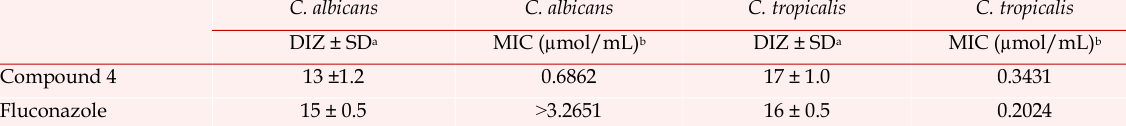
Anti-candida activity of compound 4 and fluconazole against C. albicans and C.